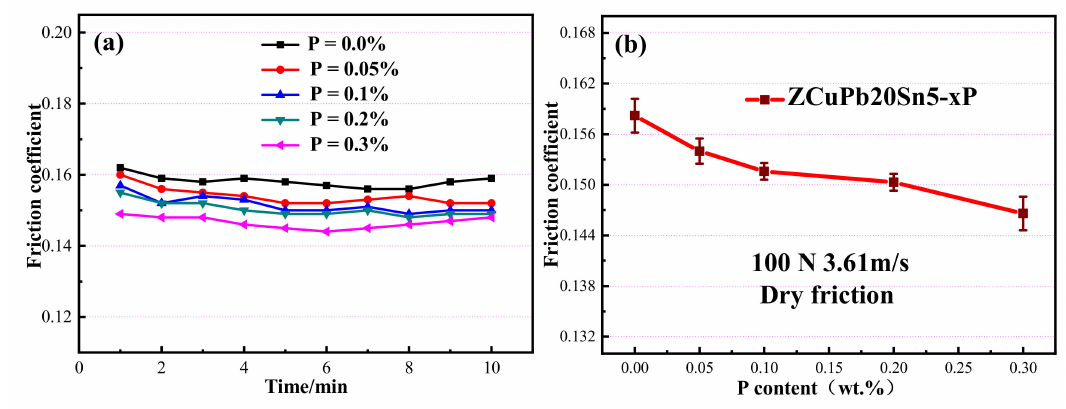
Figure 2. Friction curve of ZCuPb 20 Sn 5 − x P alloy under dry friction ( a ) time; ( b ) P